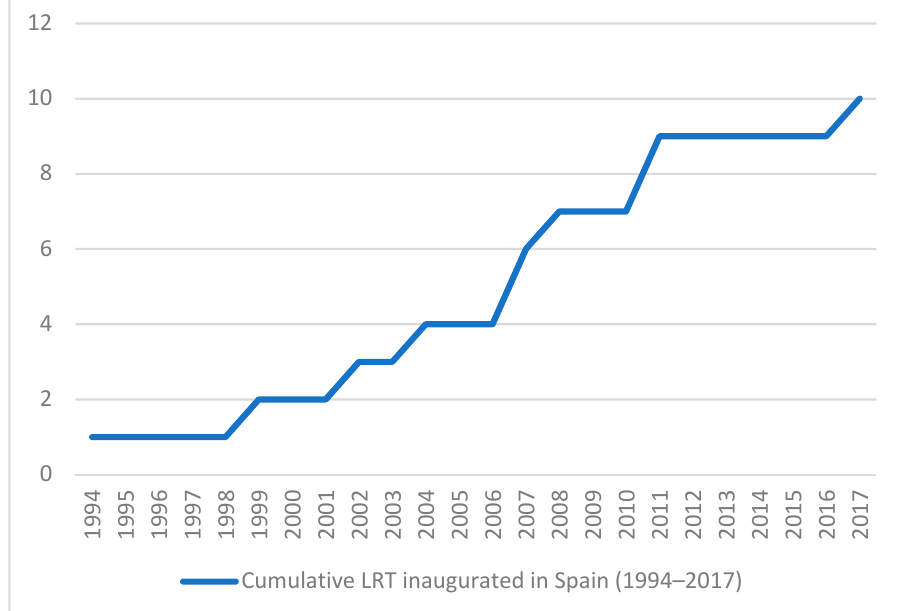
Figure 2. Cumulative LRT inaugurated in Spain (1994–2017).